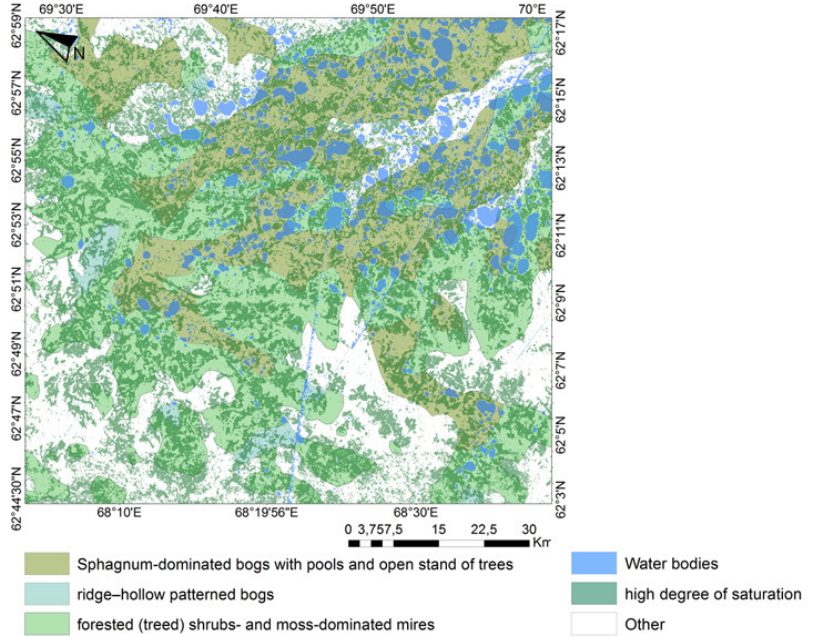
Figure 14. Classification of this study (water bodies: blue, saturated areas: green) over wetland complex classification [35]. Universal Polar Stereographic projection, extent: S3 in Figure